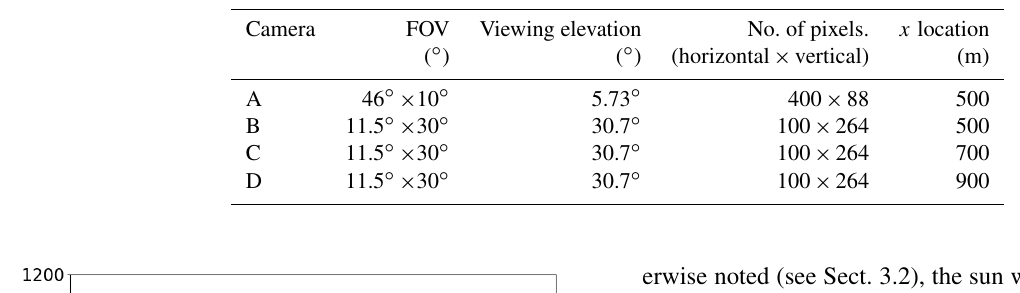
Table 1. Location and geometric specification of the four simulated cameras. All cameras were placed 1m above the surface.